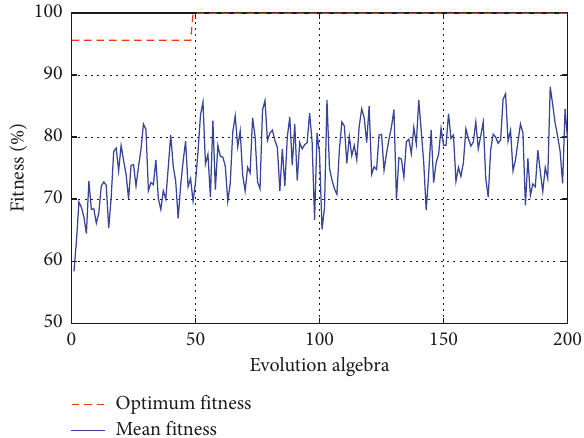
Figure 7: Experimental results of the Hilbert marginal spectrum as eigenvalues.